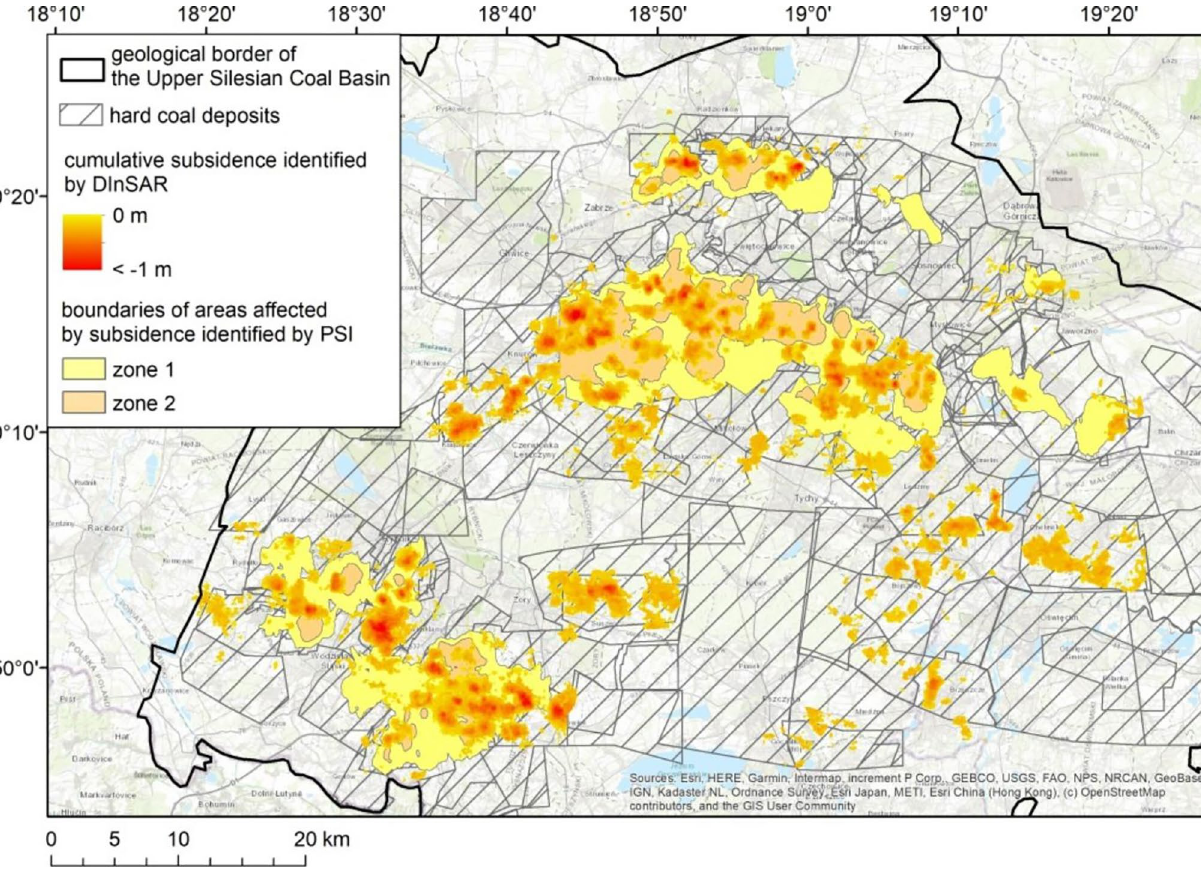
Fig. 3 a Used PSI datasets. Yellow-orange and red points represent subsidence values; b Interpolated PSI datasets with designated contour values of − 4 and − 8 mm/yr